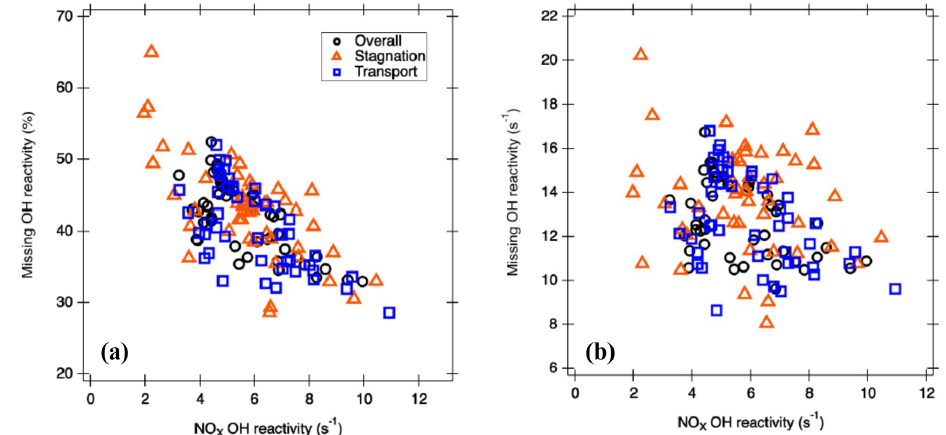
Figure 7. The correlation between NO x OH reactivity and (a) absolute missing OH reactivity and (b) percent of missing OH